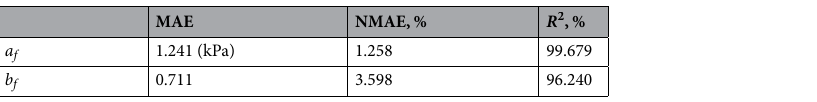
Table 6. Improvement of ML prediction errors after removing geometric features with low “importance” score and using the LV volume and endocardial surface area as the only geometric features.